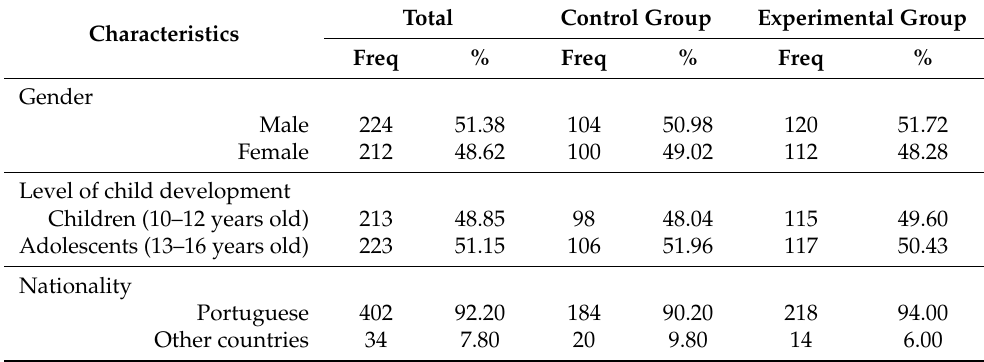
Table 1. Demographic characteristics of the